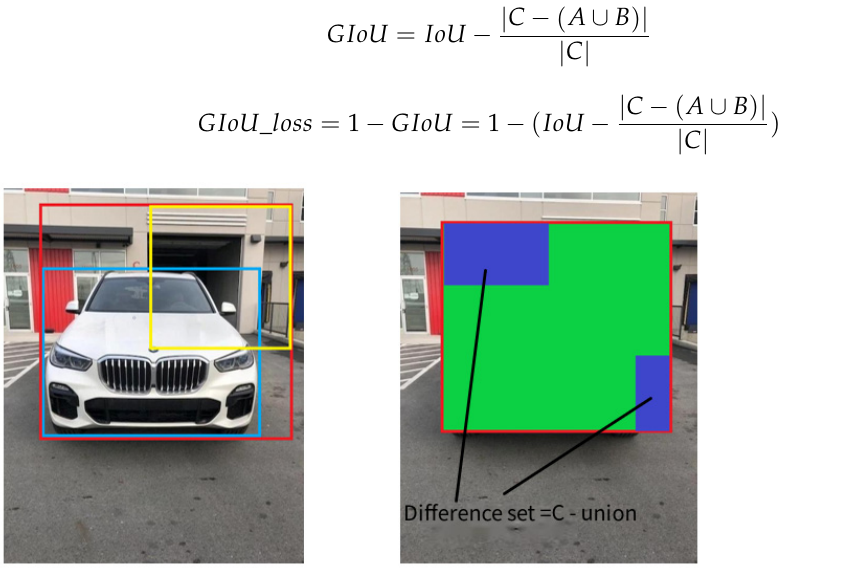
Figure 9. Schematic diagram of GIoU calculation.